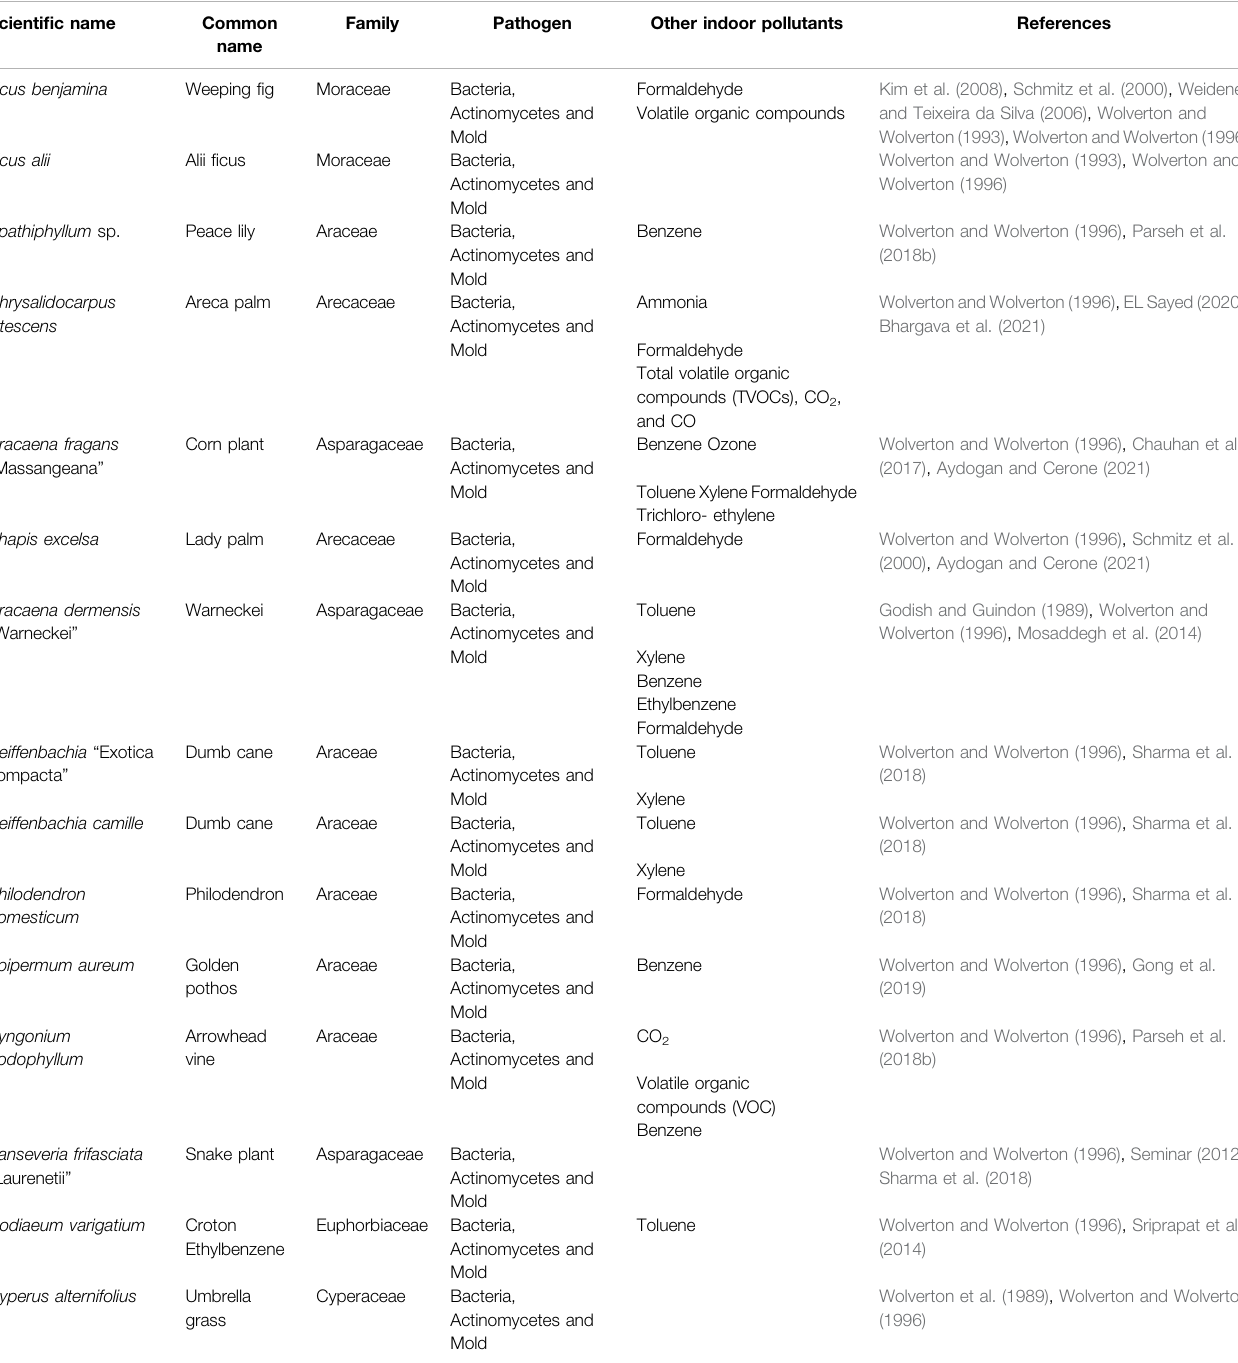
TABLE 2 | Household plants that have been tested to reduce airborne pathogens and